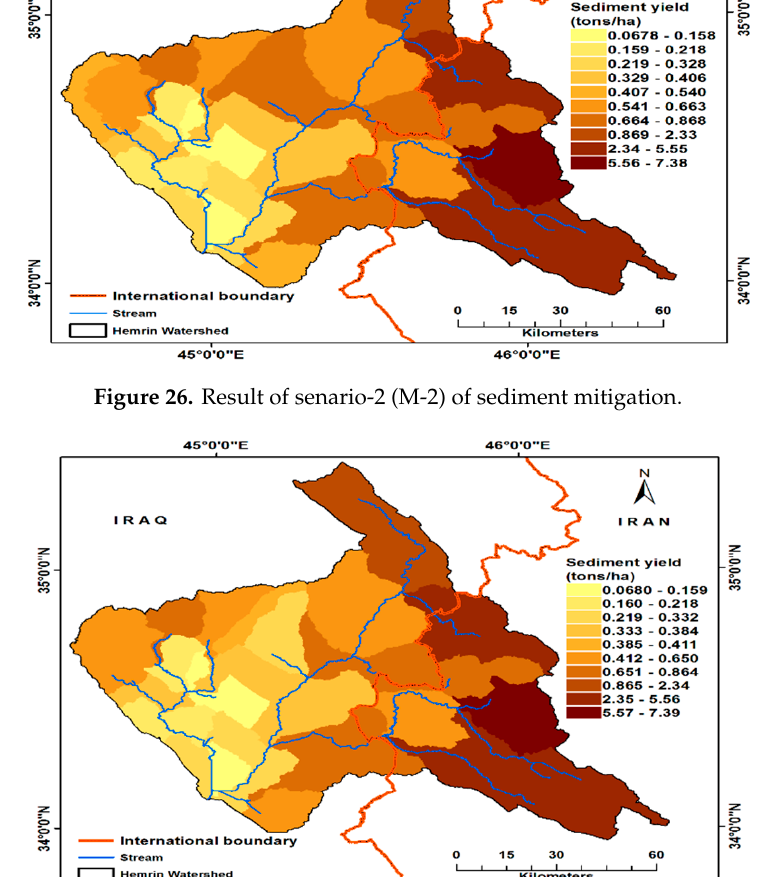
Figure 27. Result of senario-3 (M-3) of sediment mitigation.